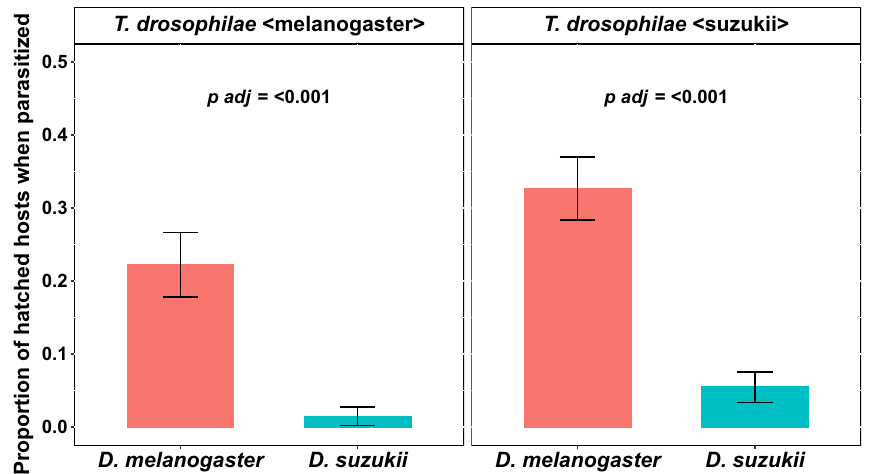
Figure 5. Mean (± SEM) Proportions of emerged hosts from parasitised hosts. The hosts were pupae of D. suzukii (blue) and D. melanogaster (red), parasitised from the wasp T. drosophilae . The wasp was reared on D. melanogaster (left side) pupae and D. suzukii (right side) pupae. In both wasp populations, D. melanogaster had a significantly higher proportion of emerged flies than D. suzukii (Wilcoxon rank-sum